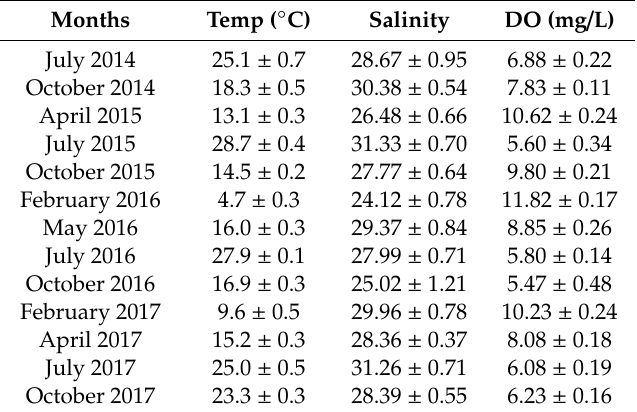
Table 1. Monthly mean ( ± SE) values of environmental parameters measured during the study